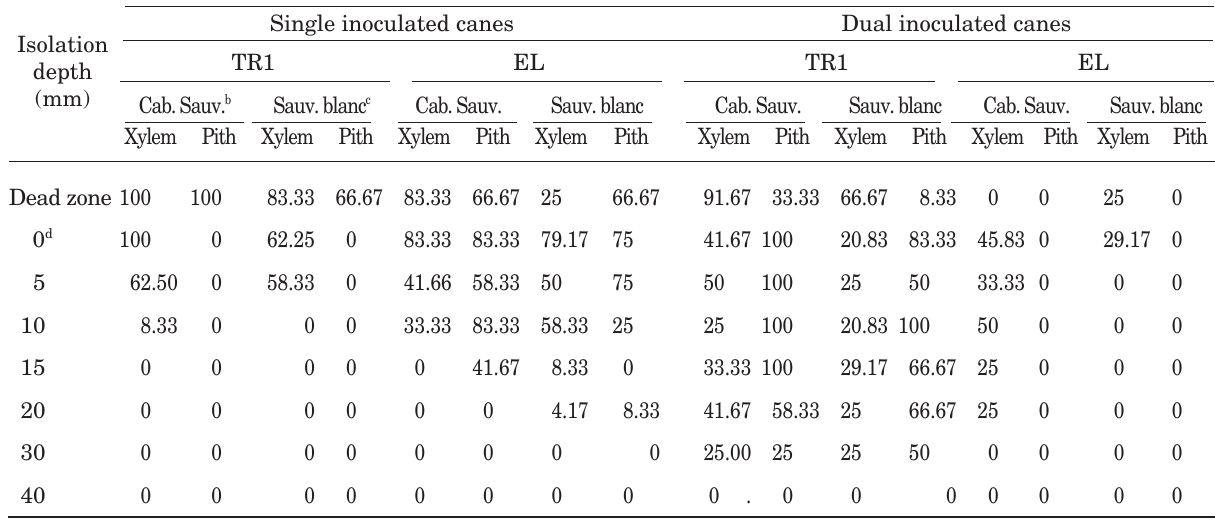
Table 2. The isolation frequency of fungi from the xylem and pith tissue at different depths 90 days after inoculation of Cabernet Sauvignon and Sauvignon blanc canes with either Trichoderma harzianum DsRed (TR1) or Eutypa lata GFP (EL) and both fungi in dual inoculation. Grapevine pieces from where the fungi were isolated (%) a Single inoculated canes Dual inoculated Isolation depth (mm)